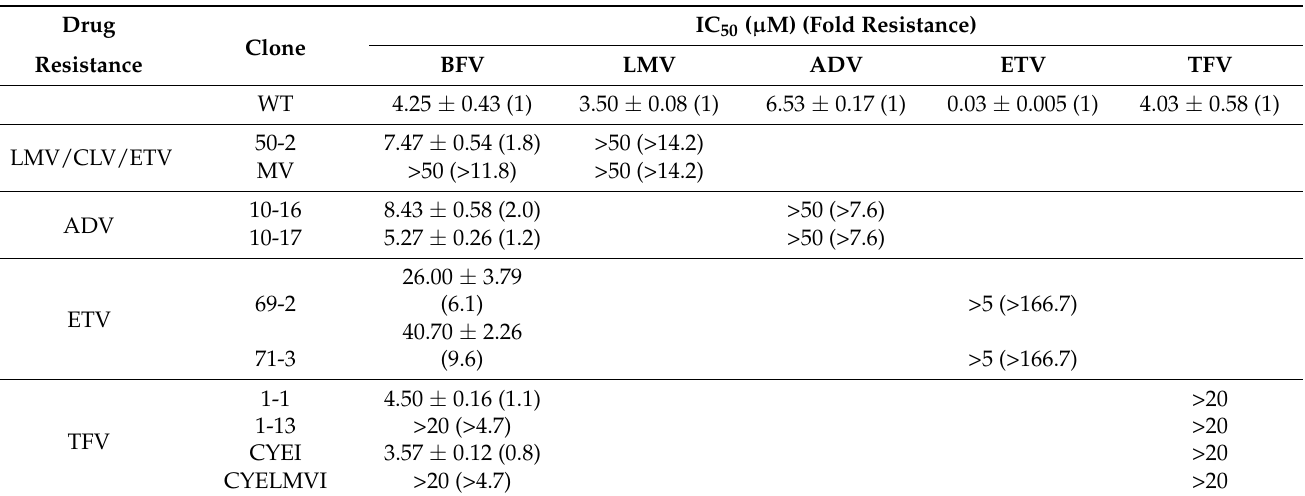
Table 1. Summary of in vitro IC 50 values of HBV clones to